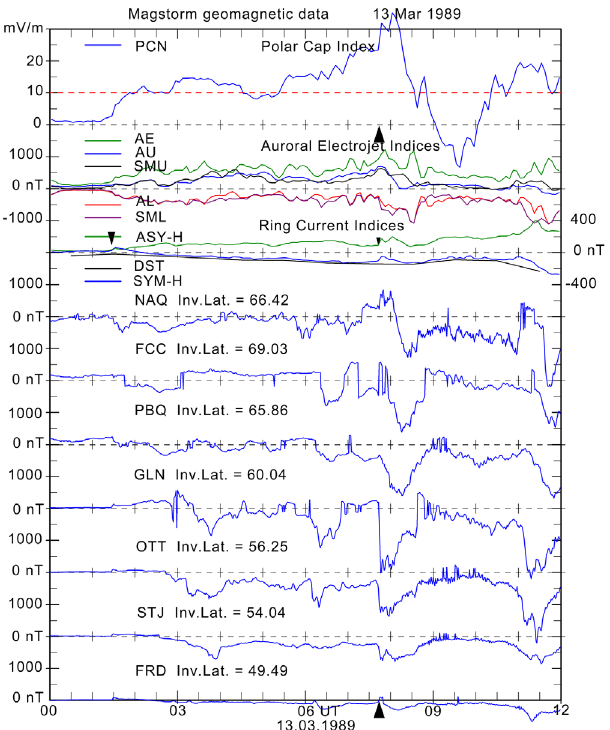
Fig. 7. Geomagnetic indices and magnetic recordings in the format of Figure 4 for 00 to 12 UT on 13 March 1989. The times and amplitudes of SSCs at 01:27 UT (60 nT) and 07:43 UT (11 nT) are indicated by the positions and sizes of downward triangular marks in the ASY-H fi eld.